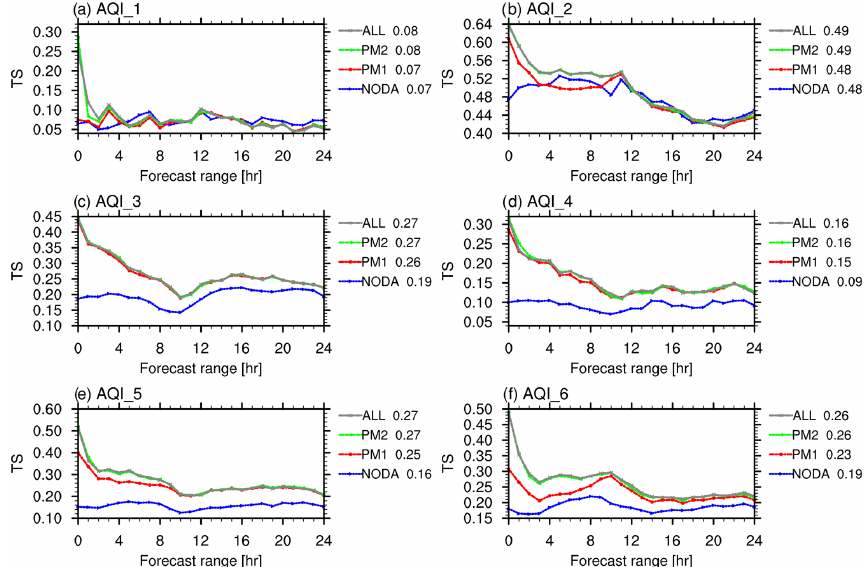
Figure 8. Averaged threat score (TS) for the Air Quality Index (AQI) from AQI level 1 to level 6 (a–f) in different experiments as a function of forecast range, verified against the surface observations of 531 stations in China. The blue, red, green, and gray lines denote the results of experiment NODA, PM1, PM2, and ALL, respectively. The numbers to the right of each panel denote the averaged TS from 0 to 24h for different experiments.